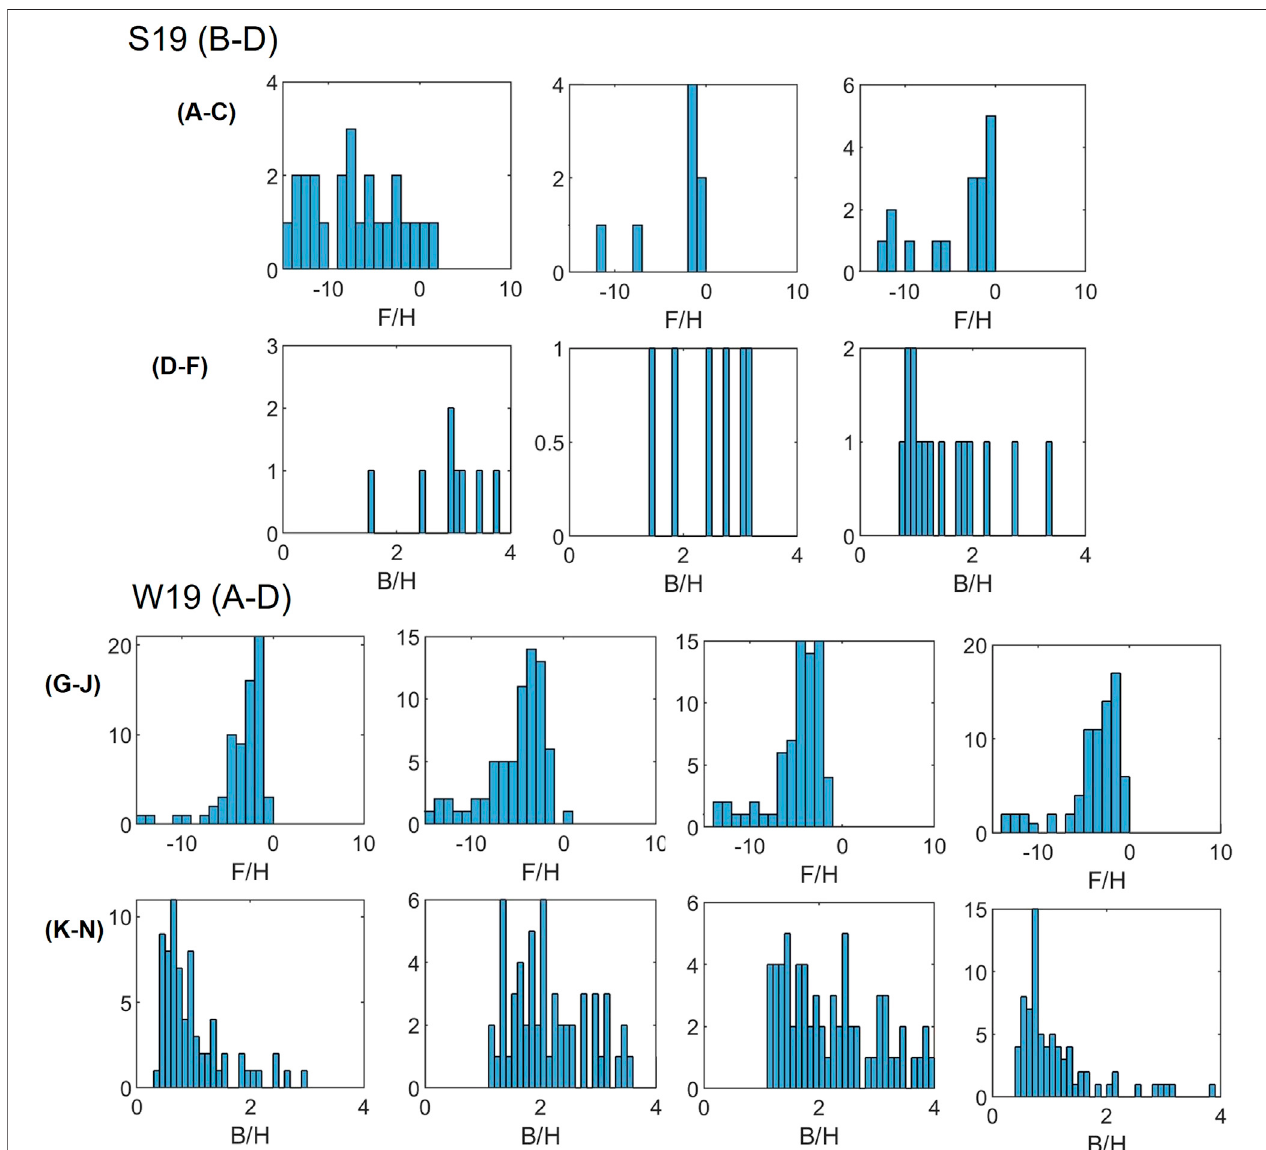
FIGURE 8 | Histograms of relative freeboard ( F/H i ) and relative crest width ( F/B ) during S19 (A – F) and W19 (G – N) at Site A (G,K) , B (A,D,H,L) , C (B,E,I,M) , and D (C,F,J,N) .